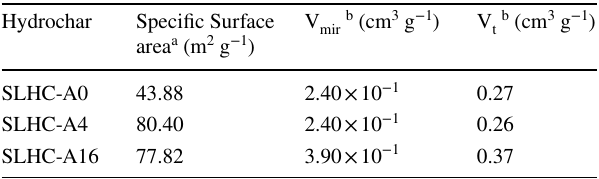
Table 3 Specific surface area and pore volume of fresh and aged sludge-derived hydrochars